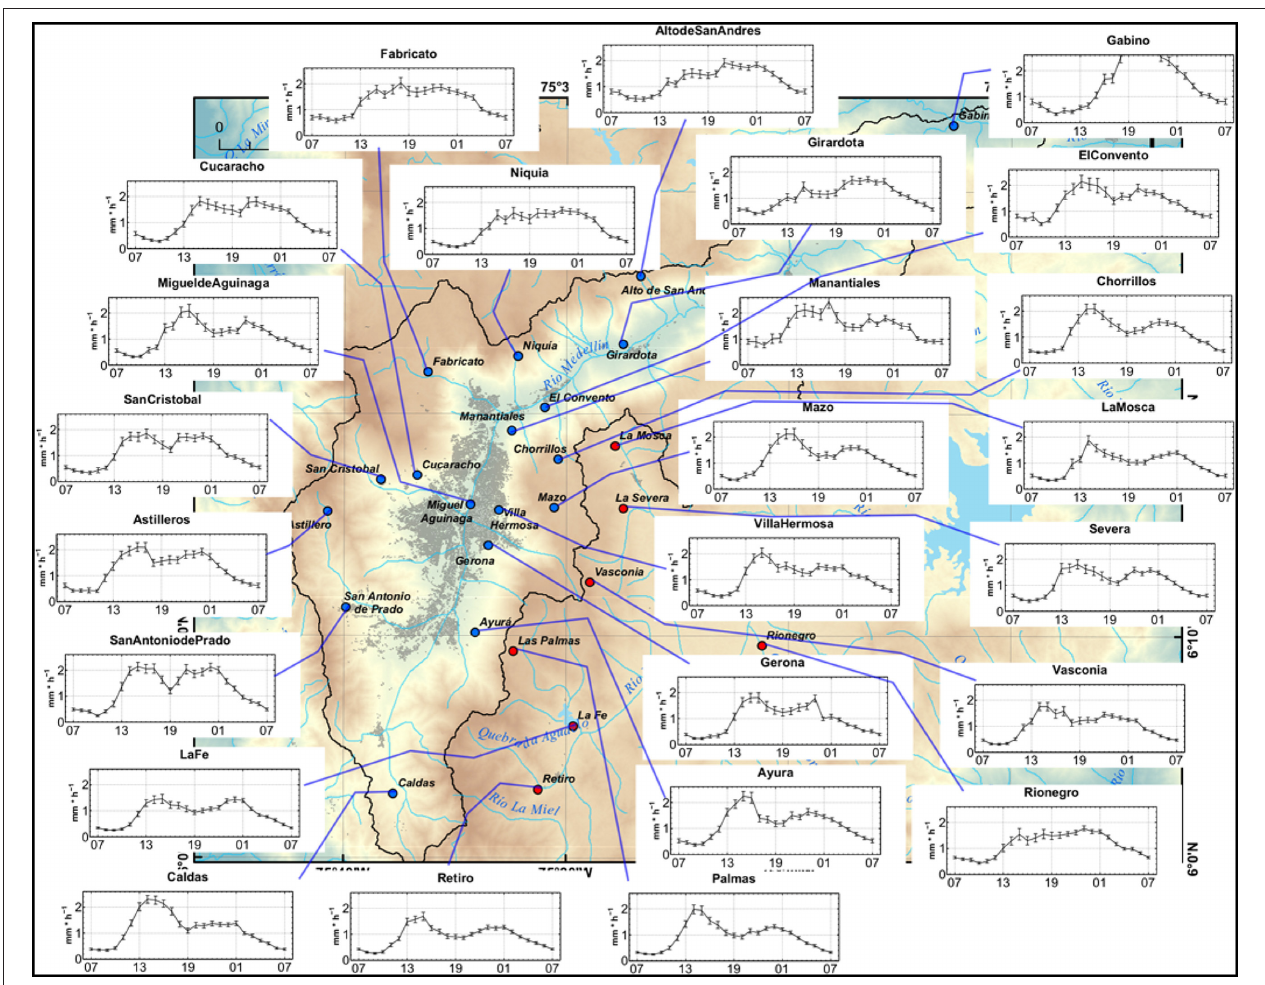
FIGURE 4 | Long-term mean (1998–2005) diurnal cycle of rainfall intensity at rain gauges over the study region (Equation 1). Error bars represent the standard error of the mean. Computations based on hourly series excluding zeros. Blue (Red) points in the map represent the raingauges located on the Aburrá Valley (San Nicolás